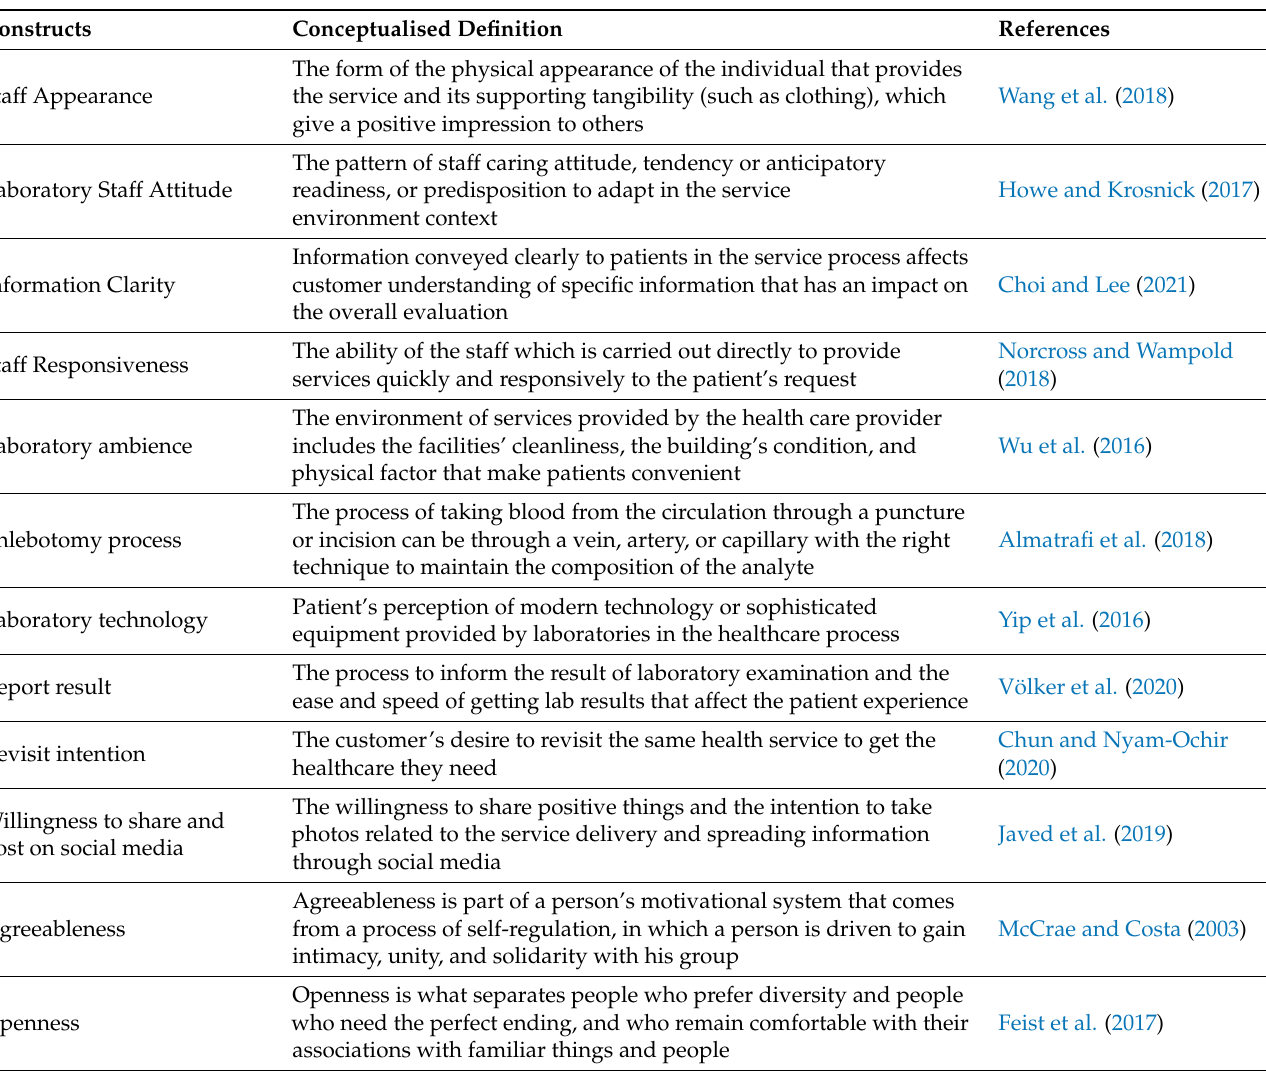
Table 1. Conceptualised definitions of